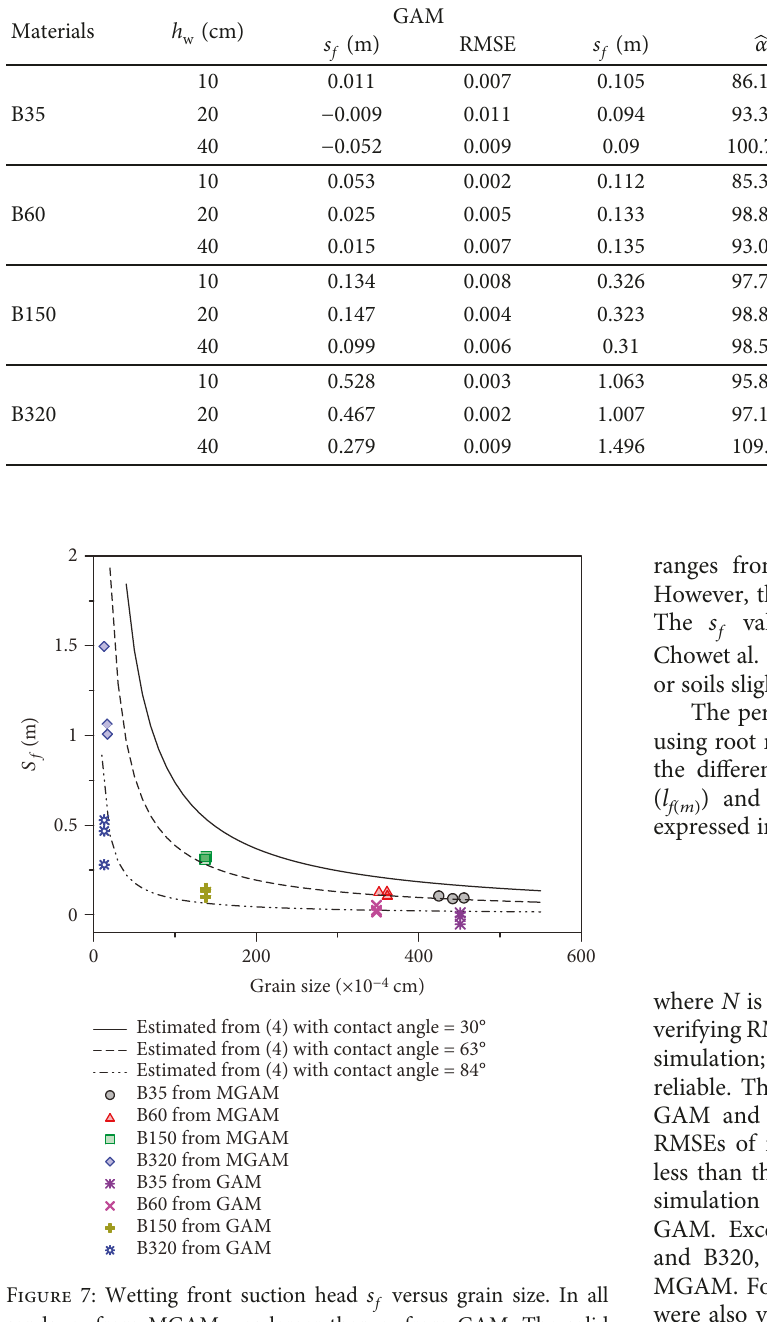
versus grain size. In all f from GAM. The solid f from MGAM, f